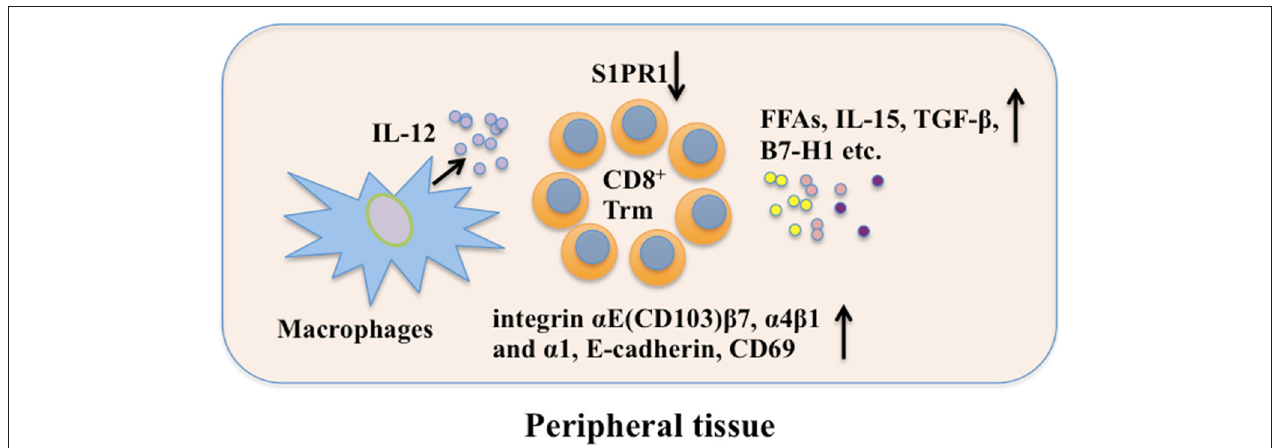
FIGURE 2 | CD8 + Trm cell maintenance. Local factors in peripheral tissue are crucial in long-term maintaining CD8 + Trm cells. CD69, E-cadherin, and integrin promote retention of CD8 + Trm while S1PR1 can mediate CD8 + Trm cell tissue egress. FFAs, IL-15, TGF- β , and B7-H1 are involved in CD8 + Trm cell maintenance. Besides, macrophages may promote CD8 + Trm cell maintenance through secreting IL-12. FFAs, free fatty acids; S1PR1, sphingosine 1-phosphate receptor-1; IL-12, interleukin-12; IL-15, interleukin-15; TGF- β , transforming growth factor- β ; B7-H1, B7 homolog 1; Trm, resident memory T cells.